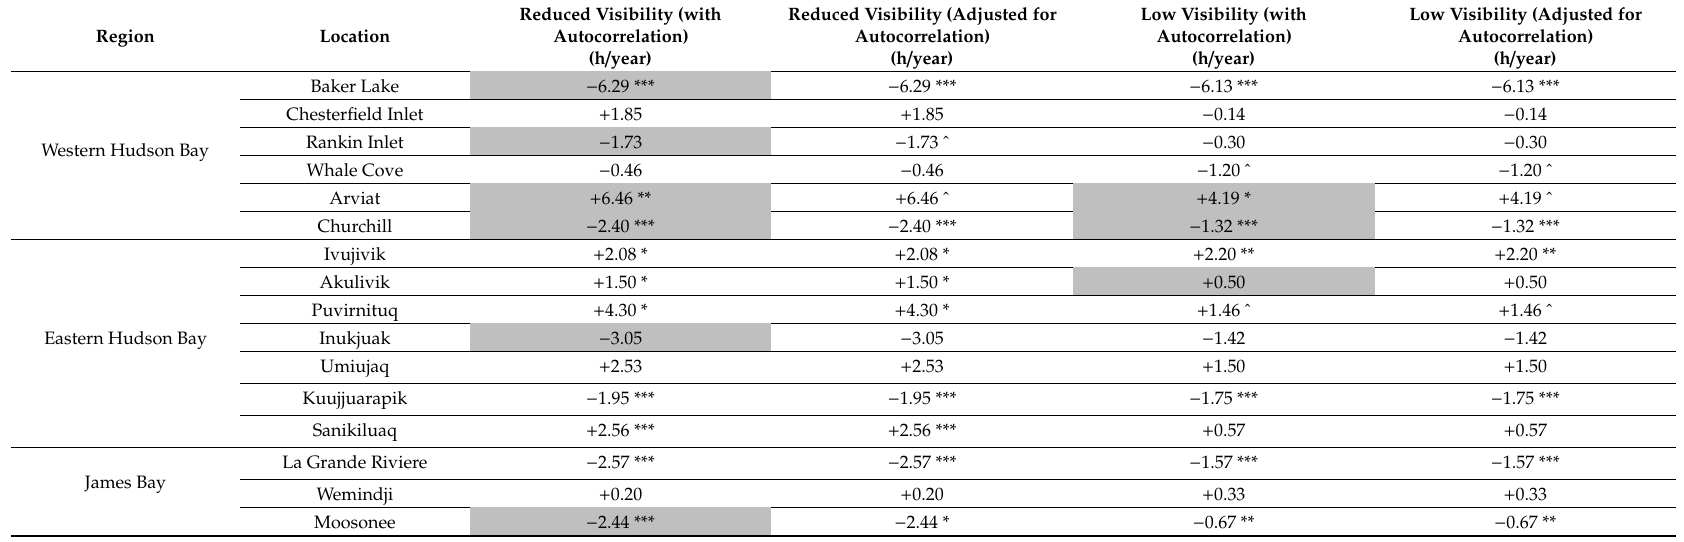
Table 6. Trends for change in number of reduced ( ≤ 0.8 km) and low ( ≤ 0.4 km) visibility hours with significance level before and after adjusted for autocorrelation. Shaded cells indicated the presence of autocorrelation. Significance level: *** p < 0.001; ** p = < 0.01; * p < 0.05; ˆ p < 0.10.